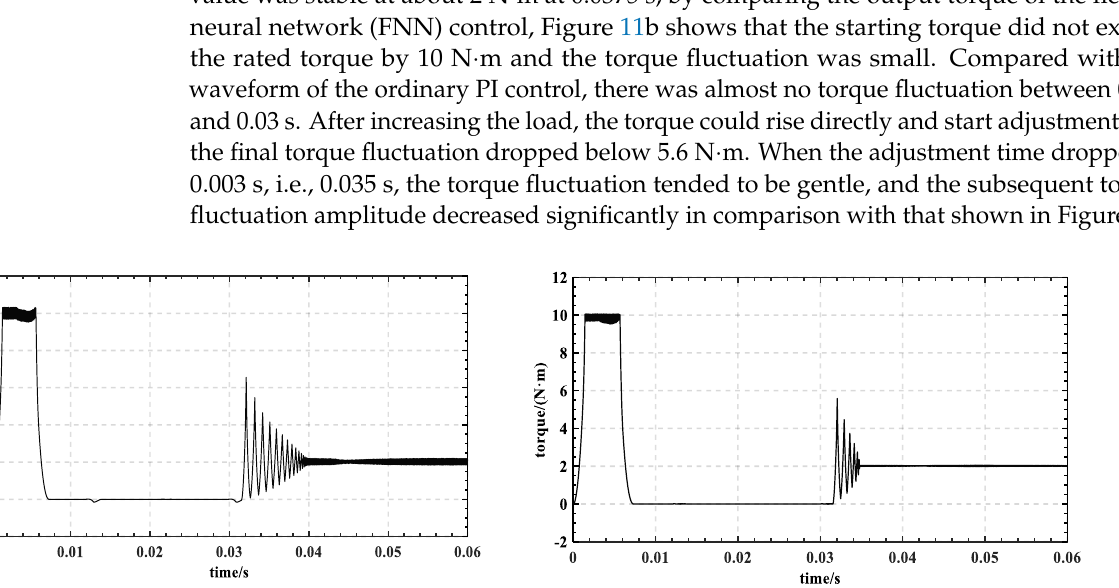
FNN control system.